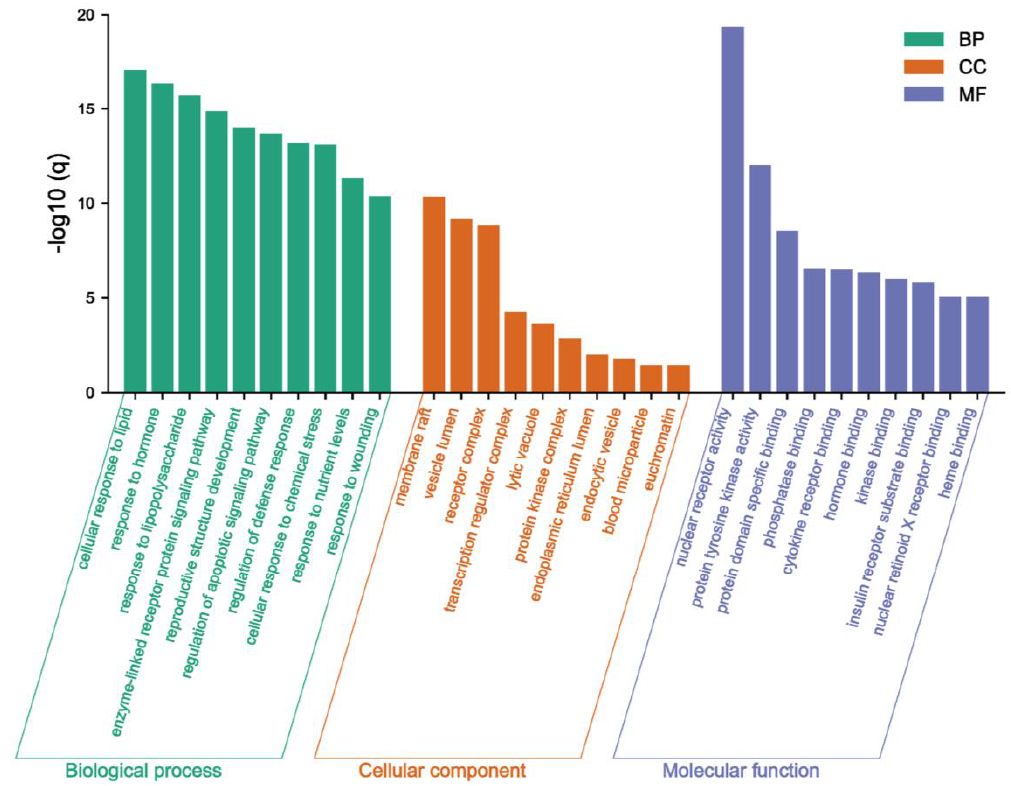
Figure 4. Gene Ontology (GO) enrichment analysis of intersecting targets of costunolide and AIH . 2.3. Topological Network Analysis of the Potential Targets of Costunolide in AIH Seventy-three potential targets of costunolide in AIH were imported into The Search Tool of Retrieval of Interacting Genes (STRING) to construct the protein – protein interac- tion (PPI) network. After removing disconnected nodes, the network contained 61 nodes and 156 edges (Figure 5a). The average number of neighbors is 5.115 and the clustering coefficient is 0.317. Using plug-in CytoHubba, we found top 10 genes that might play crit- ical roles in the therapeutic effect of costunolide in AIH, namely MAPK1, SRC, GRB2, EGFR, LCK, ESR1, JAK2, IGF1, HSP90AA1, and IGF1R, ranked by Maximal Clique Cen- trality (MCC) (Figure 5b).